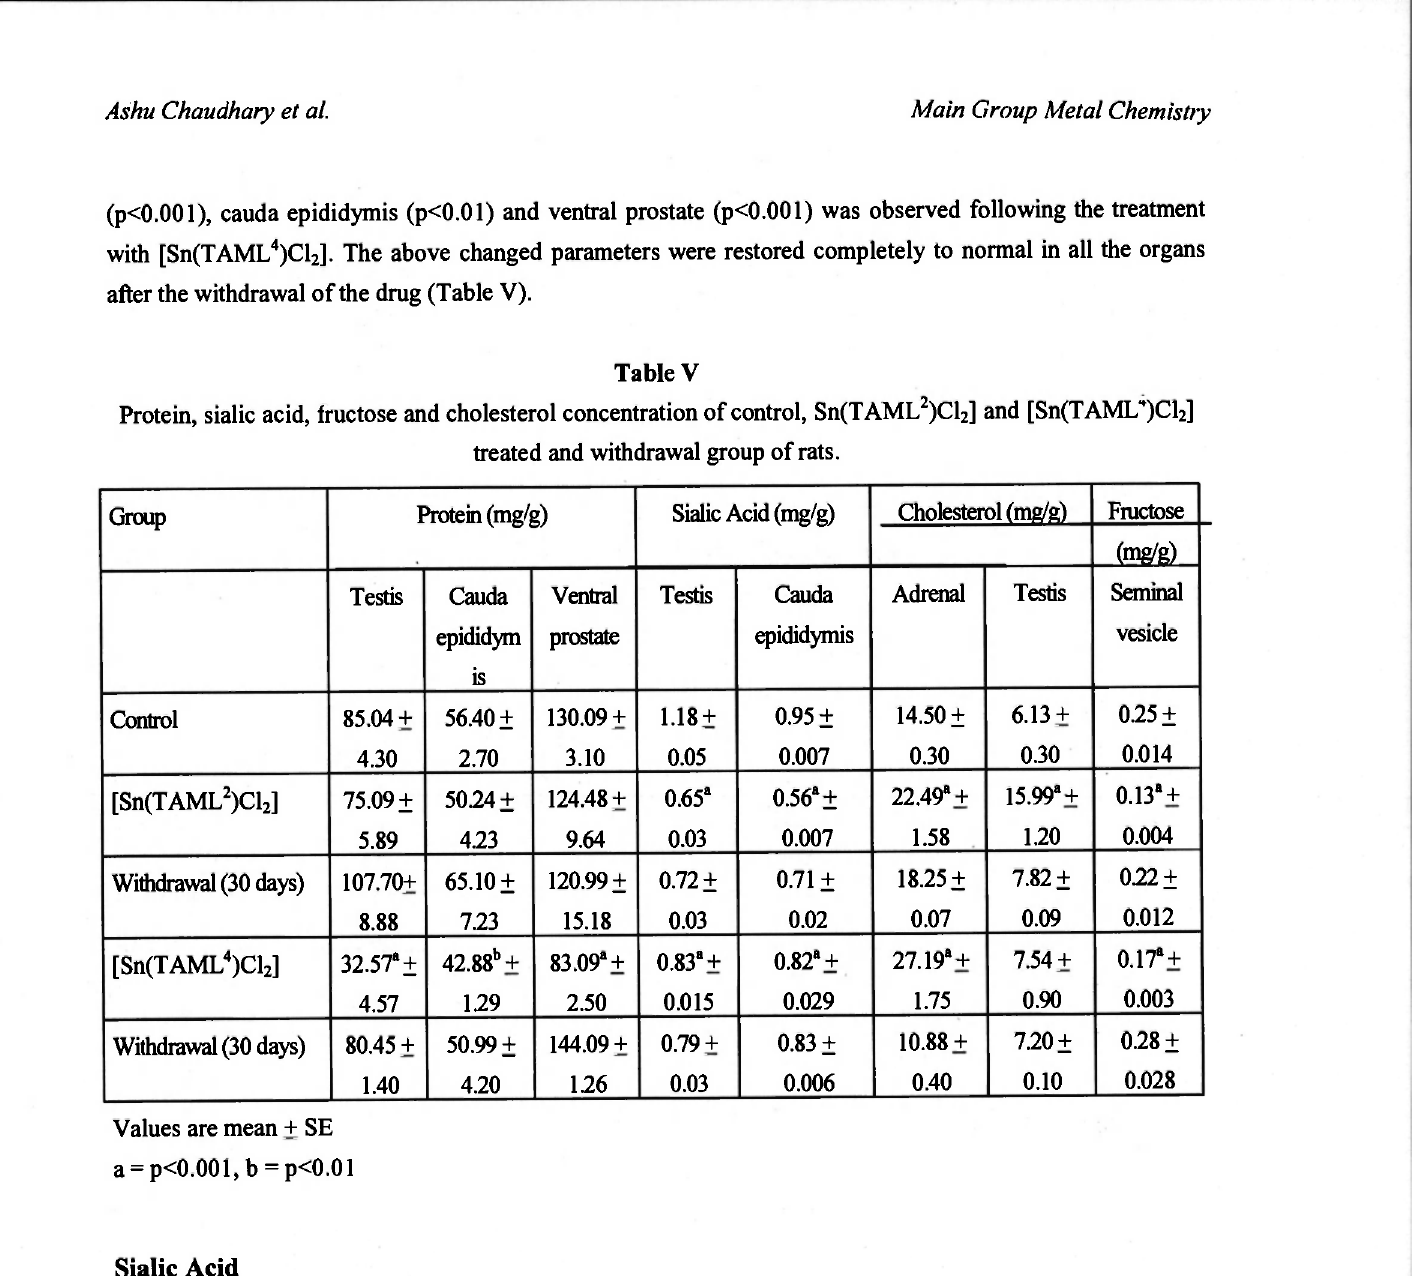
Protein, sialic acid, fructose and cholesterol concentration of control, Sn(TAML 2 )Cl